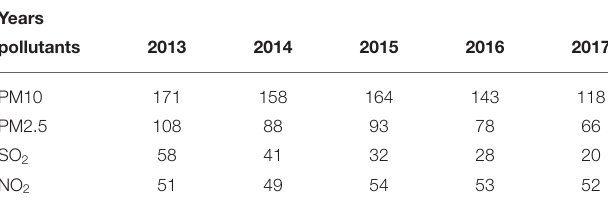
TABLE 2 | Concentration of atmospheric particulate pollutants of Z City from 2013 to 2017 (Unit: µ g/m 3